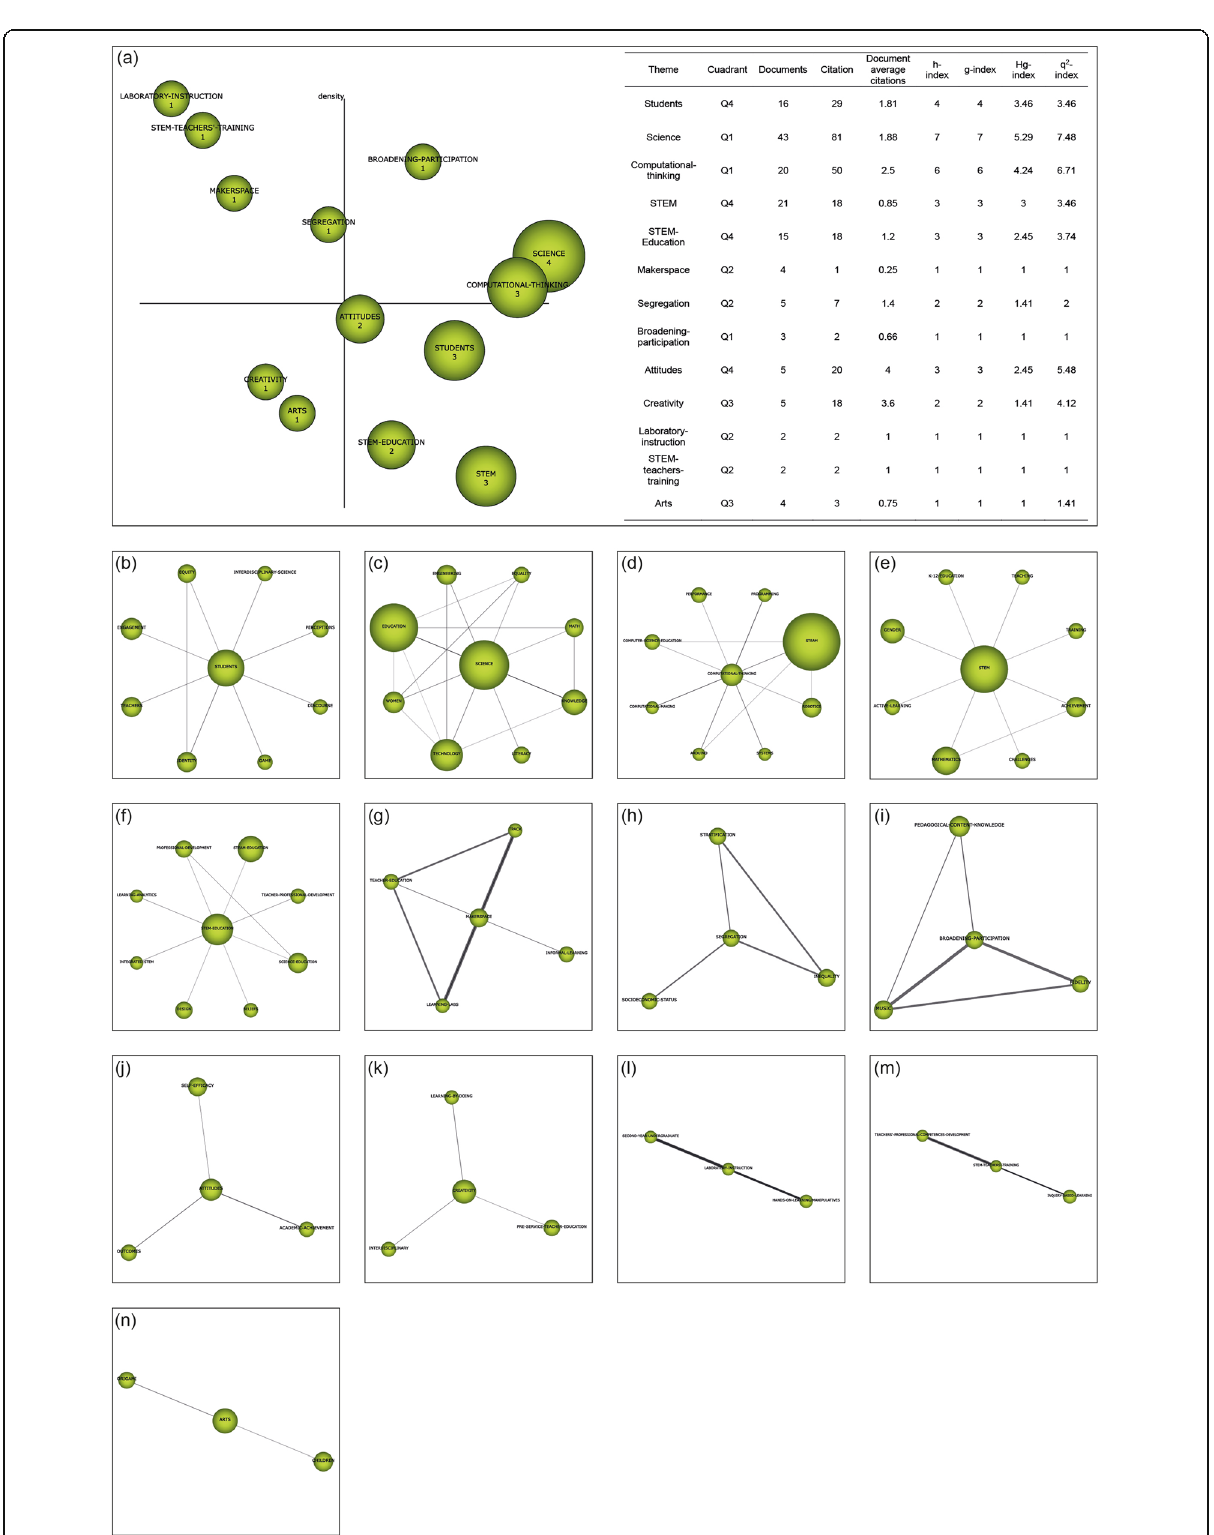
Fig. 7 Strategic diagram of the 2019 to 2020 period. Note: a Strategic diagram (h-index) and performance from 2019 to 2020. Themes include b “ students, ” c “ science, ” d “ computational-thinking, ” e “ STEM, ” f “ STEM-Education, ” g “ makerspace, ” h “ segregation, ” i “ broadening-participation, ” j “ attitudes, ” k “ creativity, ” l “ laboratory-instruction, ” m “ STEM-Teachers-training, ” and n “ arts